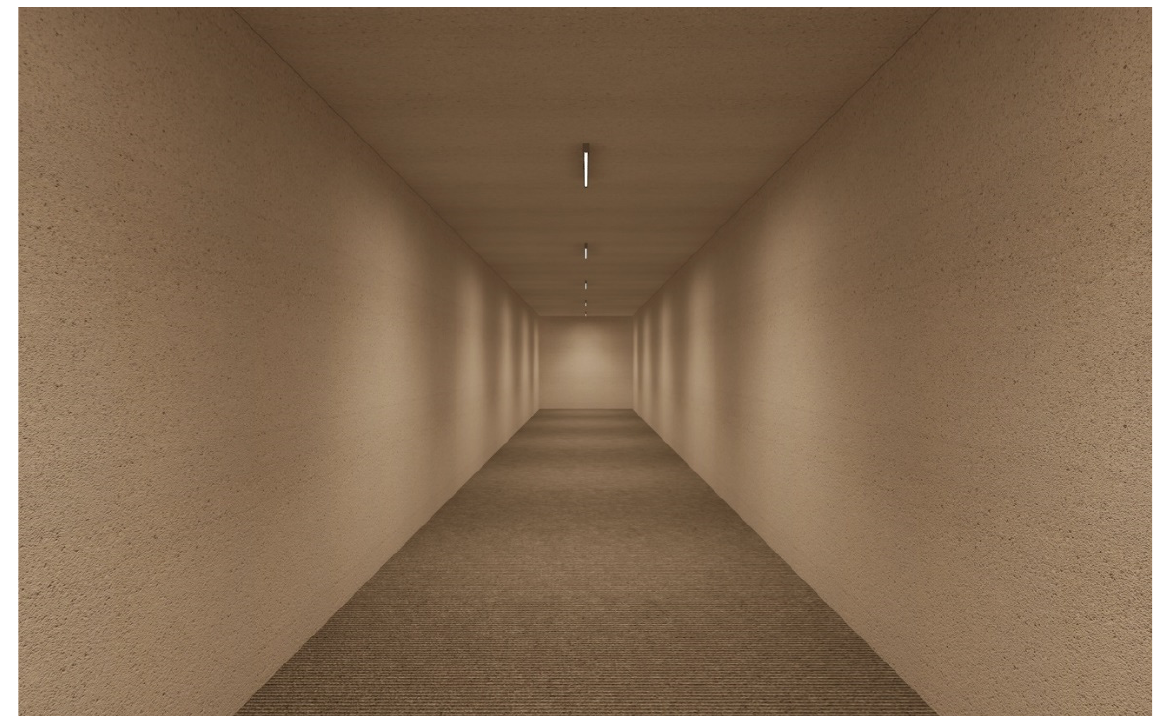
Figure 7. Computer simulation of corridor lighting for variant 4.